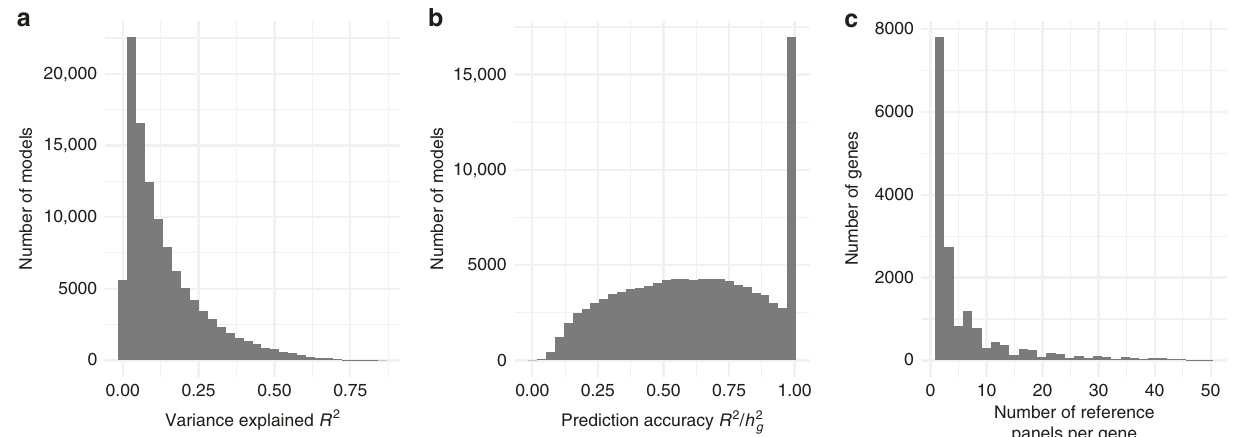
Fig. 1 Tissue-speci fi c predictive models for gene expression. a Cross-validation prediction accuracy of cis-regulated expression and splicing events ( R 2 ) for all 109,170 tissue-speci fi c models. b Normalized prediction accuracy ( R 2 = cis (cid:1) h 2 ) for all 109,170 tissue-speci fi c models. c Histogram of the number of g reference panels per gene. The majority of genes were heritable in a small number of tissues, but many genes exhibited heritable levels across